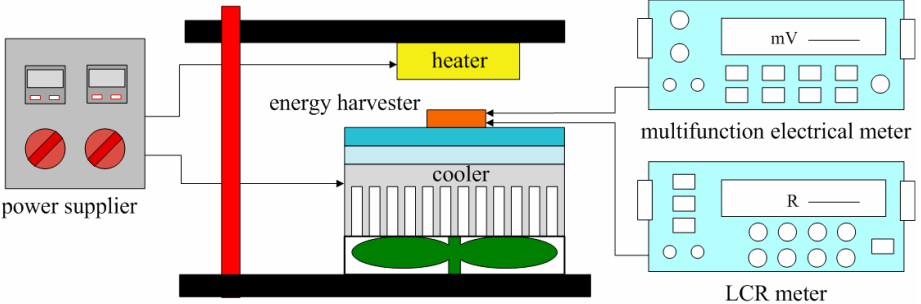
Figure 7. Measurement setup for the thermoelectric energy harvester.